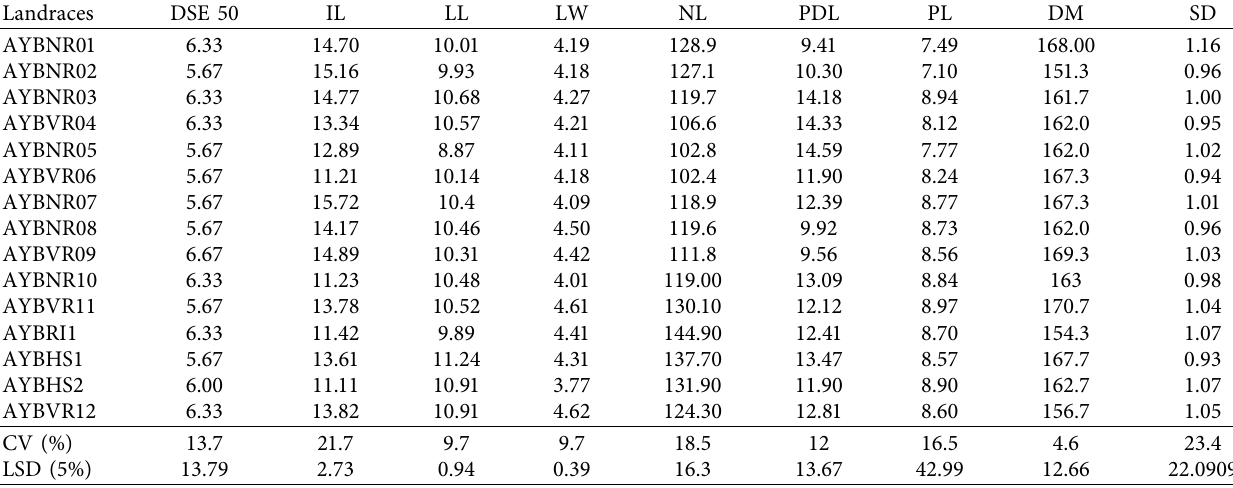
Table 3: Te mean performances of the vegetative traits of the